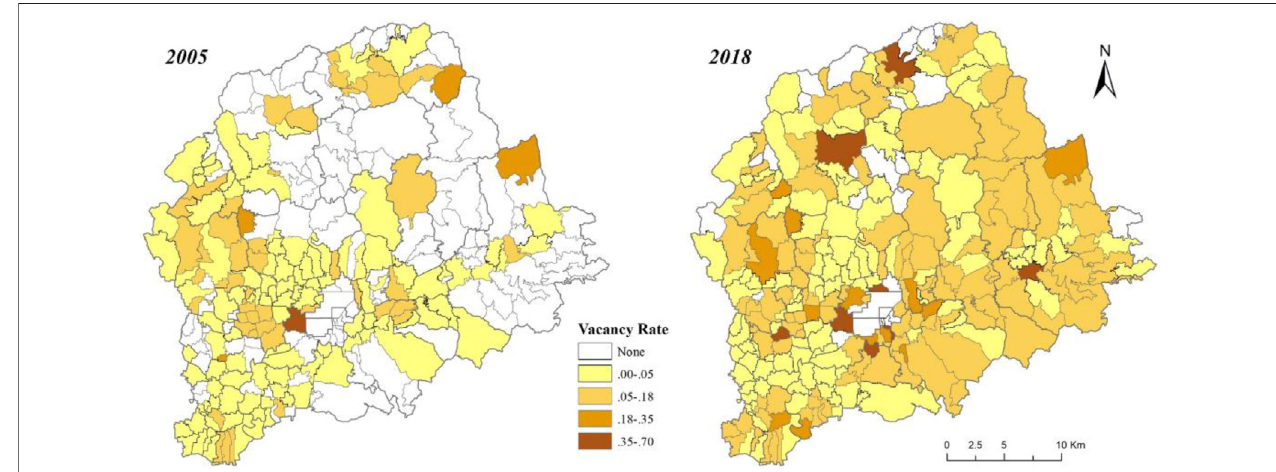
FIGURE 5 | Changing patterns of residential vacancy from 2005 to 2018.